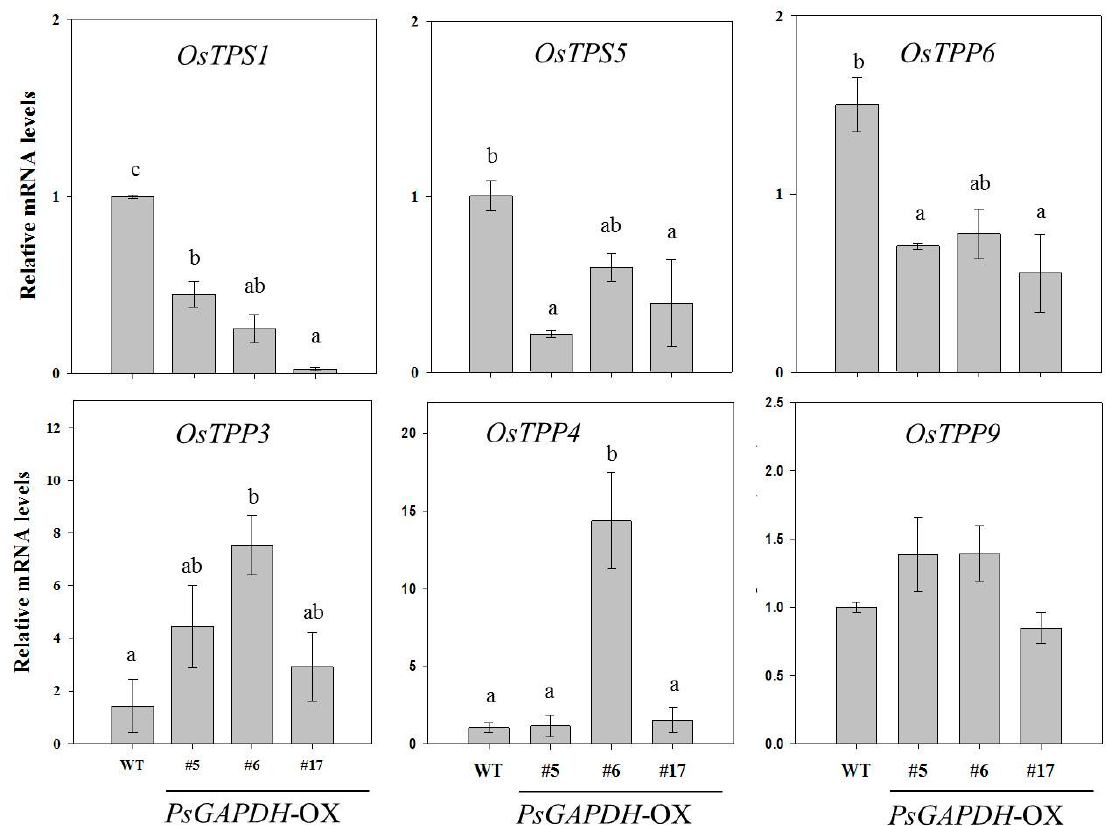
Figure 8. Expression levels of starch and sucrose-associated genes in wild-type and PsGAPDH -OX plants under NaCl stress conditions. Quantitative real-time PCR data were analyzed using the 2 − ∆∆ CT method with OsActin1 gene as an internal control. Values are presented as means ± SD of three independent measurements. Different lowercase letters indicate significant differences (ANOVA with Tukey’s HSD, p < 0.05).